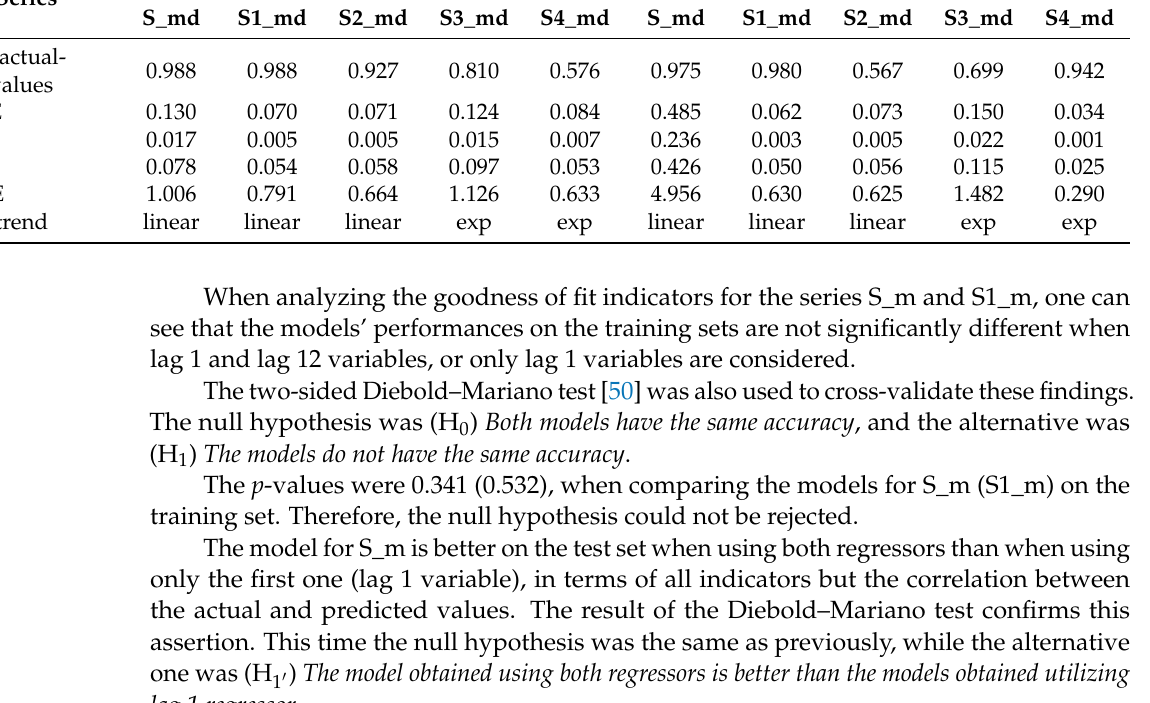
Table 7. Performances of the best models built for the detrended monthly series with lag 1 variable as regressors.